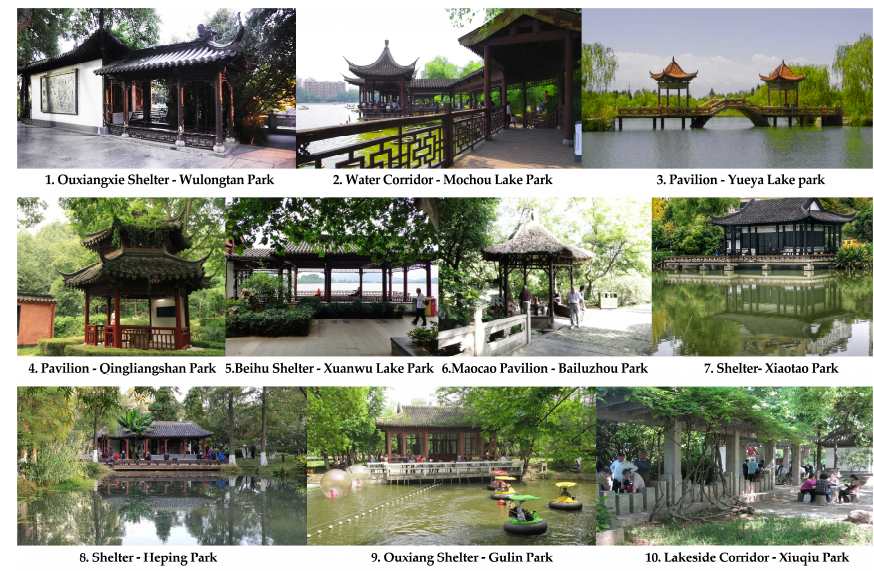
Figure 3. Photos of the 10 amenity buildings included in the study. Int. J. Environ. Res. Public Health 2020 , 17 , x